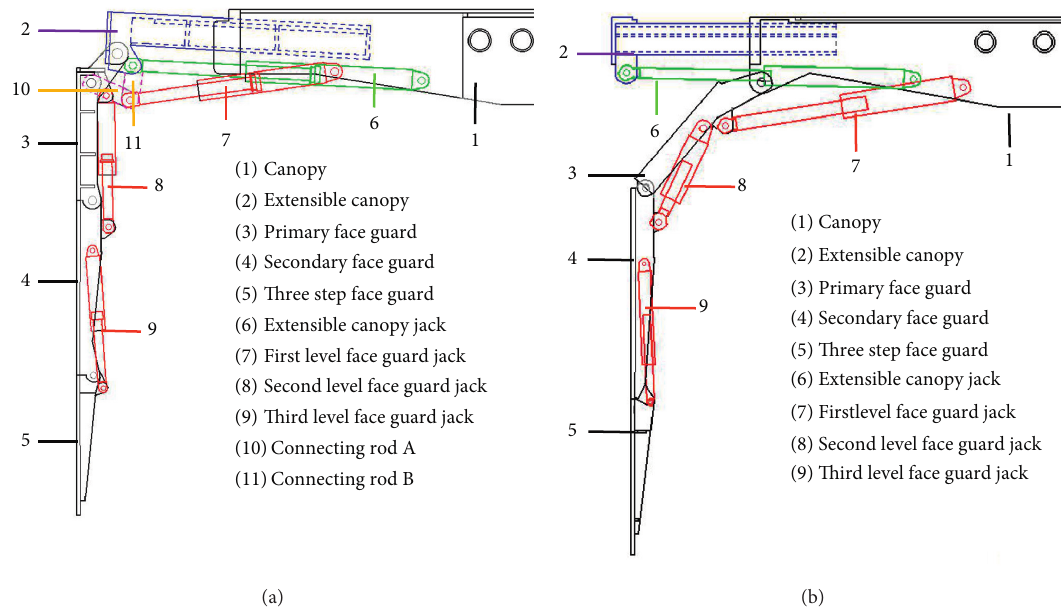
Figure 2: Comparison of the two kinds of hydraulic support face guard mechanisms. (a) Integral face guard. (b) Split face